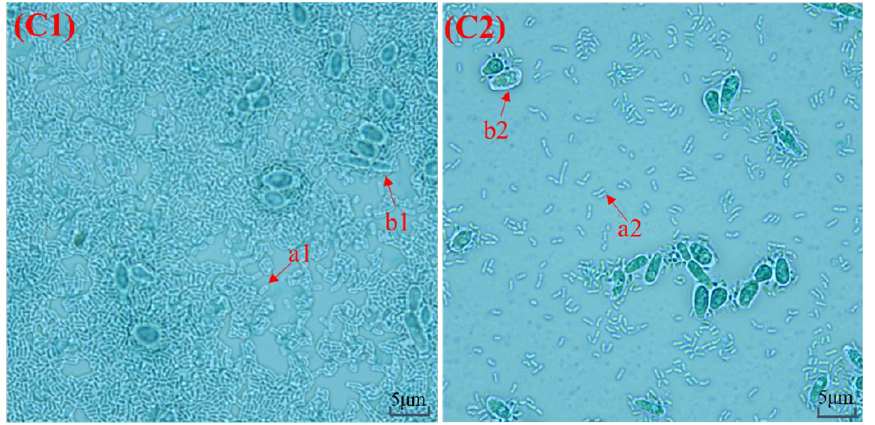
Figure 1. The integrated ( A1 , A2 ) and expanded partial ( B ) macroscopic observation and microscopic observation ( C1 , C2 ) of K1 and K2 from Tibet.